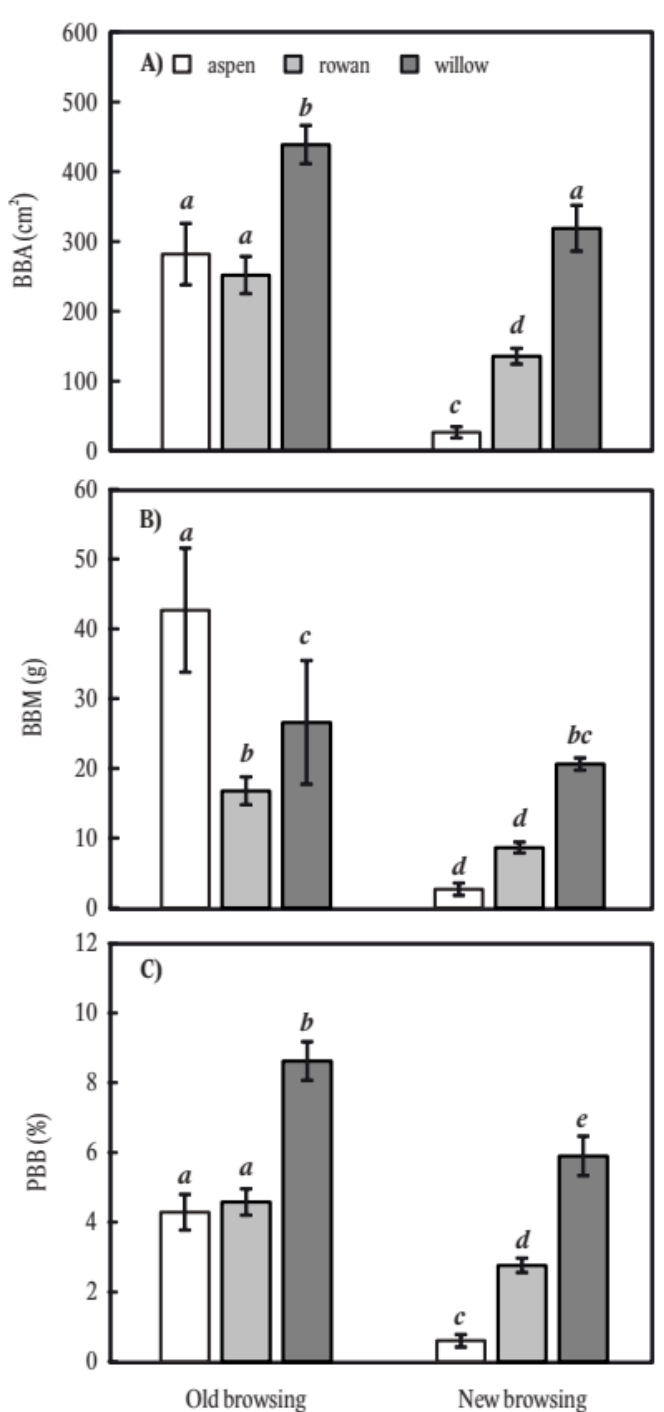
Figure 1. Stem bark browsing on common aspen ( Populus tremula L.), common rowan ( Sorbus aucuparia L.), and goat willow ( Salix caprea L.) considering old (2019 and 2020) and new (2021) wounds. The stem browsing is expressed on the basis of area ( A ), mass ( B ) and the proportion of browsed bark mass to full bark mass potential ( C ). The error bars indicate standard errors. The different letters above the error bars indicate significant differences (three-way ANOVA and LSD test with alpha-level of 0.05).